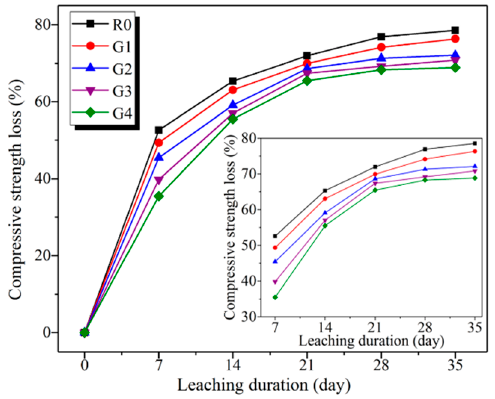
Figure 8. Compressive strength loss of the leached samples in relation to leaching duration.